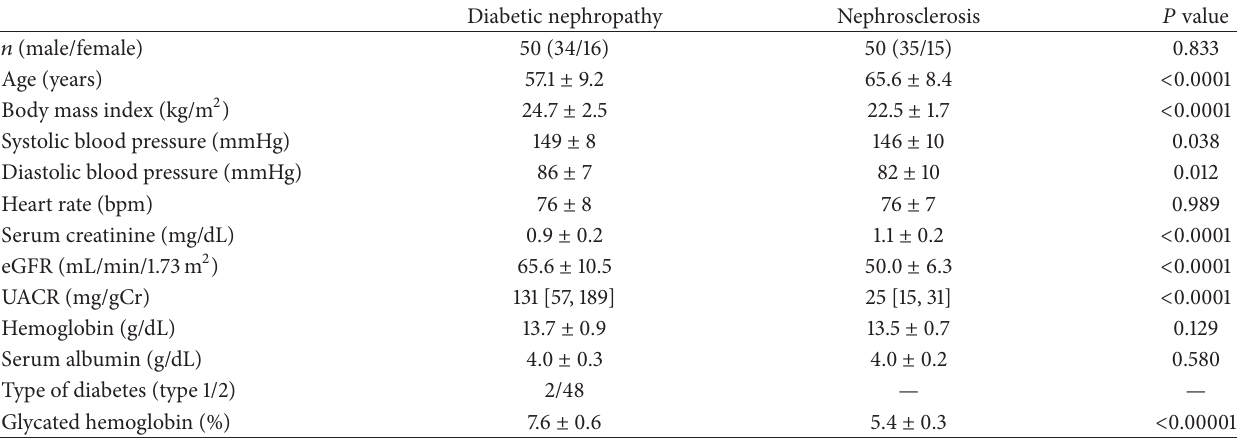
Table 1: Clinical characteristics at the first visit in the two groups.